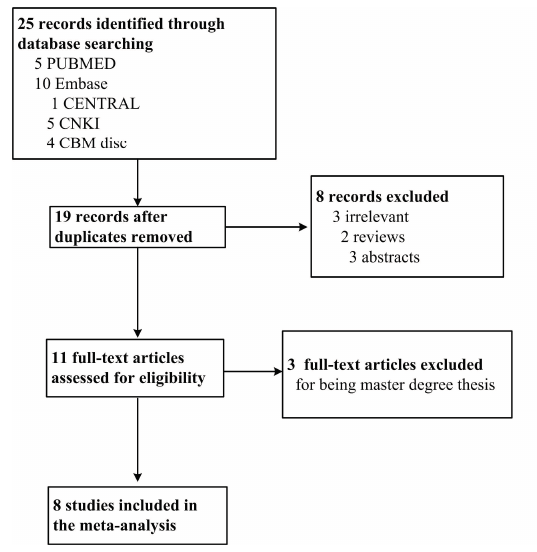
Figure 1. PRISMA flow chart of studies inclusion and